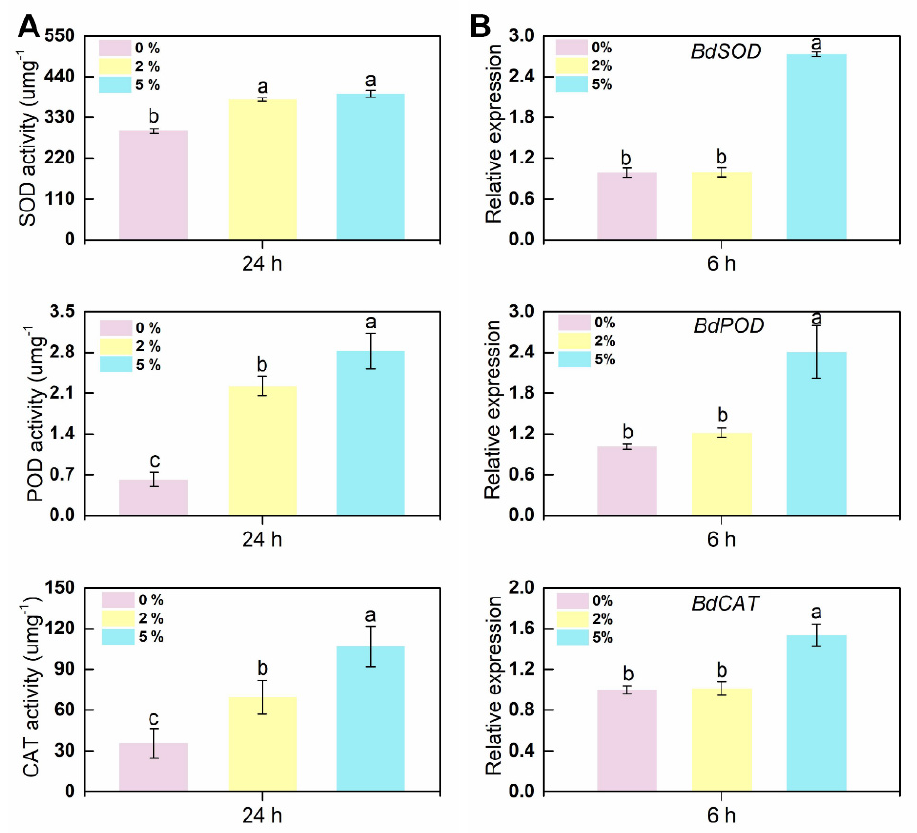
Figure 5. Effects of CFS on the enzyme activities involved in scavenging reactive oxygen species in B. dothidea . ( A ) The activities of ROS scavenging enzymes (POD, SOD, and CAT) were recorded in harvested hyphal cells. ( B ) Gene expression levels of BdSOD , BdPOD, and BdCAT at 6 h after treatment. Different letters above the columns indicate significant differences within each group according to Duncan’s multiple range test ( p < 0.05).